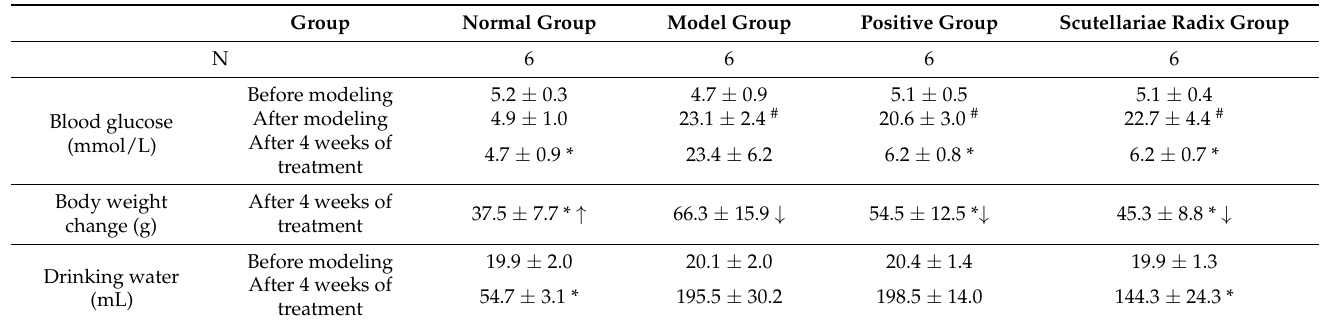
Table 4. The levels of blood glucose, body weight and drinking water before and after modeling (mean ± SD).